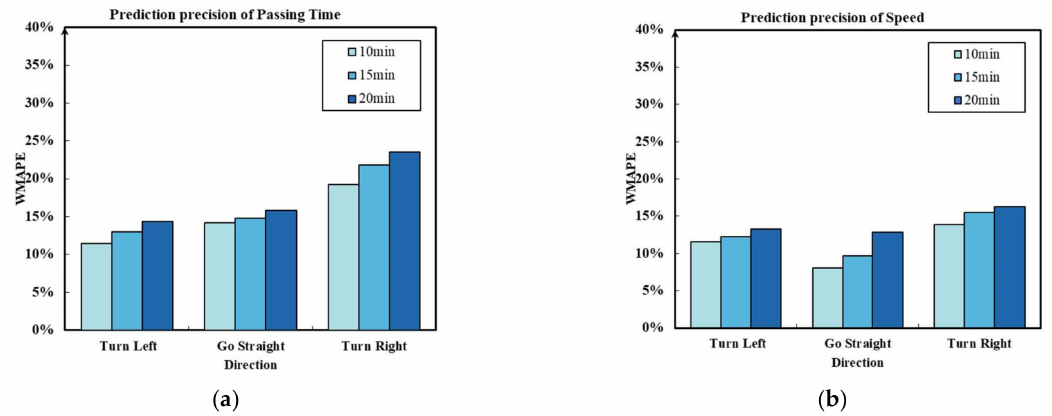
Figure 18. Prediction precision of the passing time and speed in different directions. ( a ) the prediction precision of the passing time; ( b ) the prediction precision of